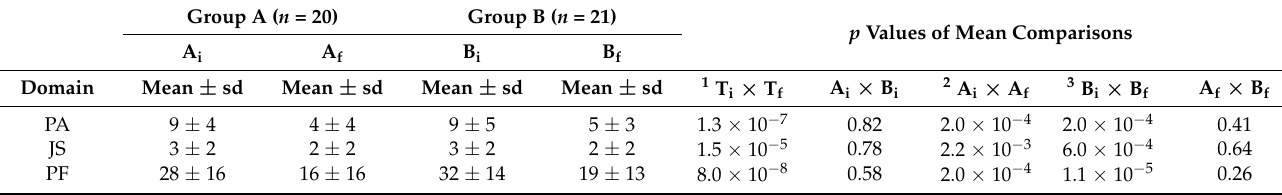
Table 2. Mean and standard deviation of patient scores in the Western Ontario and McMaster Universities Osteoarthritis Index (WOMAC) evaluation and p -values for comparisons between the beginning (i) and end (f) of the treatment for the whole group (T), and intra- and intergroup comparisons (A and B). Results are considered statistically significant for p <